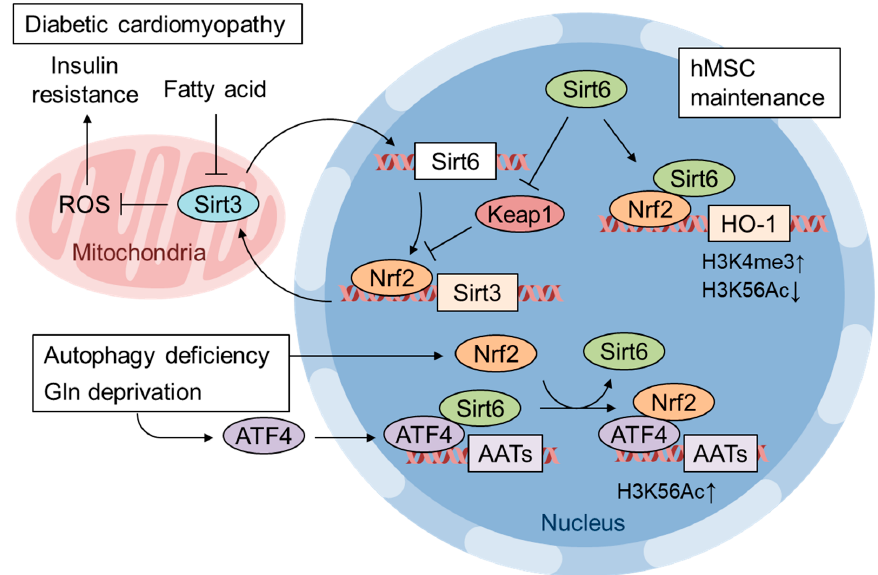
Figure 5. Regulation of gene expression by Nrf2 and Sirt6 crosstalk. Sirt6 expression restores Nrf2 and Sirt3 expression and improves diabetic cardiomyopathy. Sirt6 activates Nrf2 by repressing